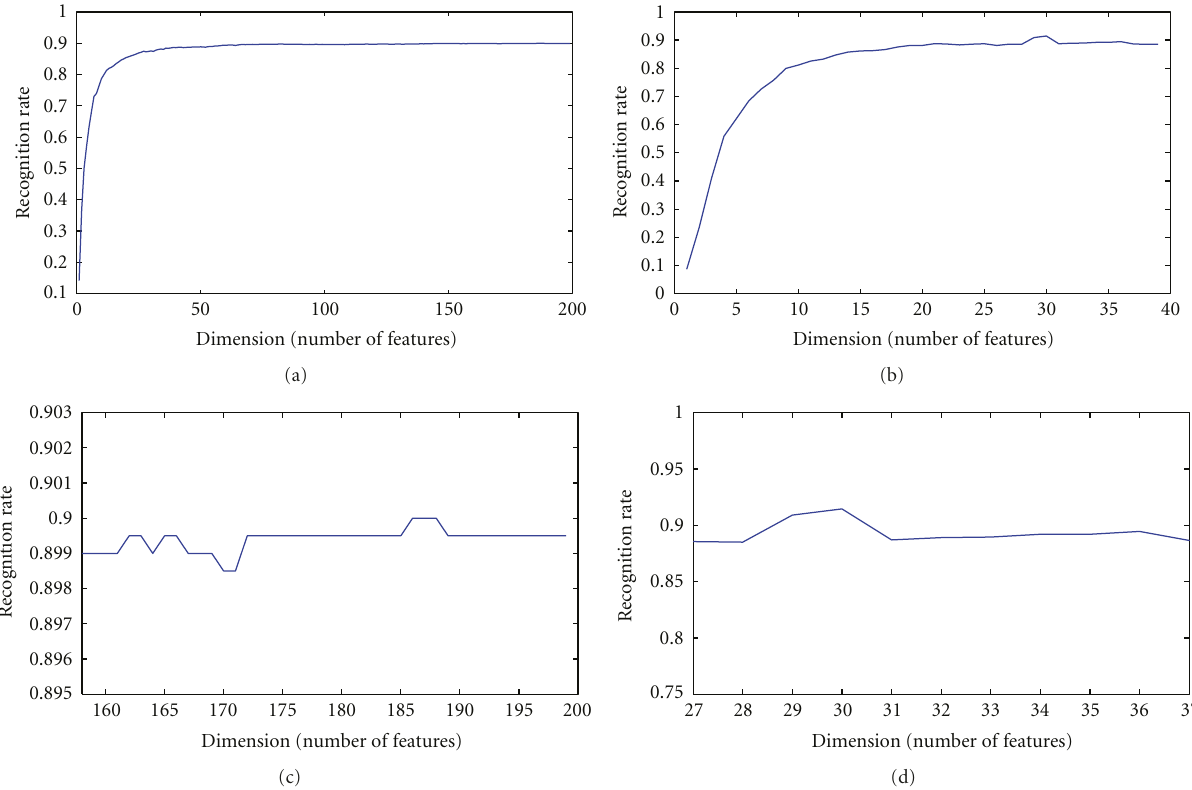
Figure 4: The curves of the average recognition accuracy of (a) Eigenfaces and (b) Fisherfaces on the ORL face database versus the number of features or the dimension of feature subspaces. (c) and (d) are the corresponding enlarged last parts of the